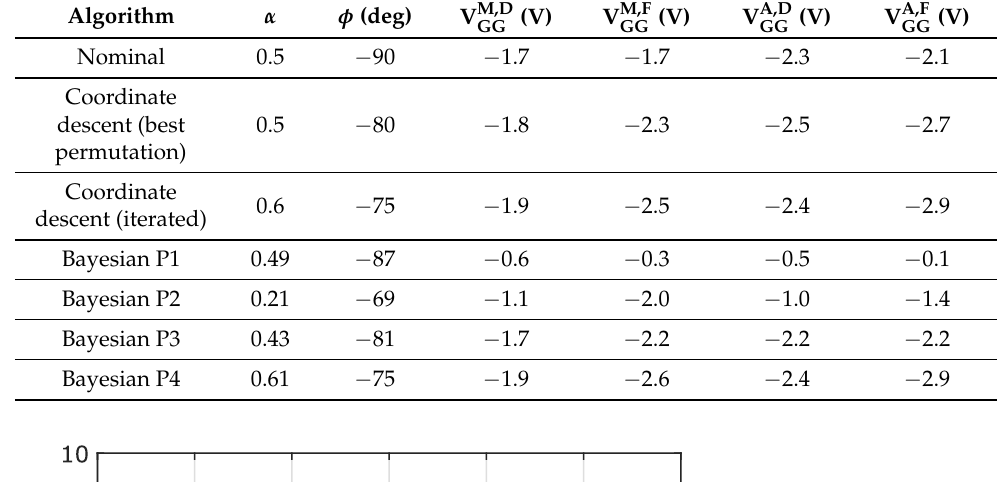
Table 7. Nominal values of the parameters considered for DIDPA optimization.